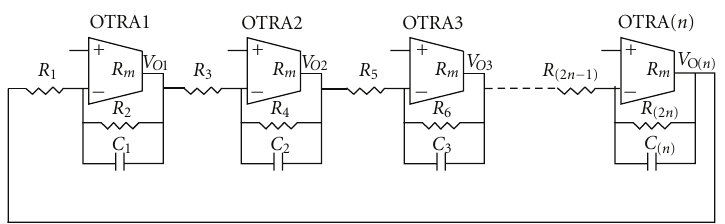
Figure 2: Generalized scheme for producing n odd-phase oscillation.